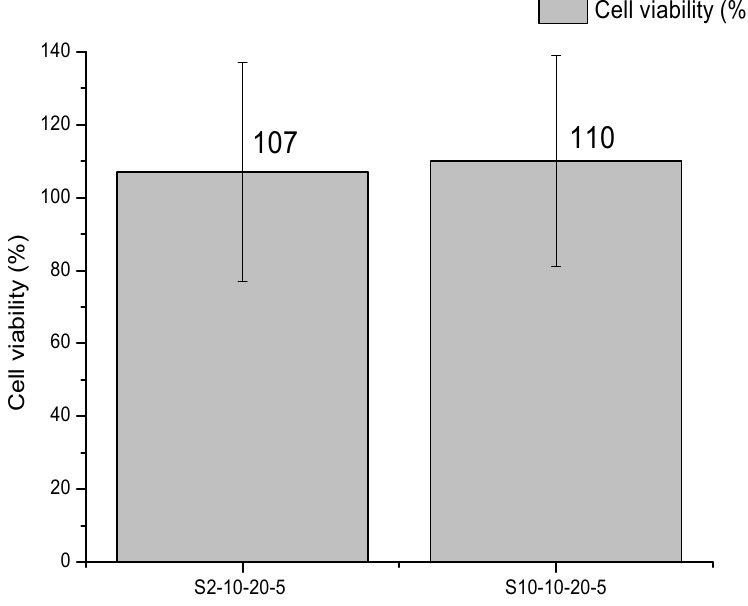
Figure 8. Cell viability of L929 cell lines (when in contact with the S 2 − 10 − 20 − 5 and S 10 − 10 − 20 − 5 spheres) by the 3 − (4,5 − Dimethylthiazol − 2 − yl) − 2,5 − diphenyltetrazolium bromide (MTT)